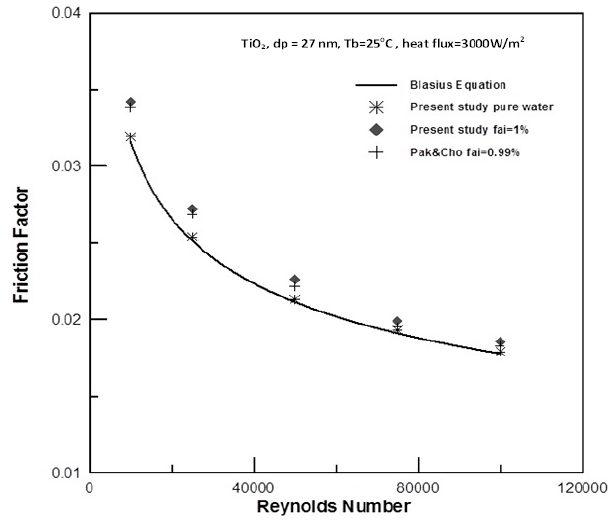
Figure 5. Comparison CFD results of friction factor with Pak and Cho experimental data [7]. Math. Comput. Appl. 2018 , 23 , x FOR PEER REVIEW